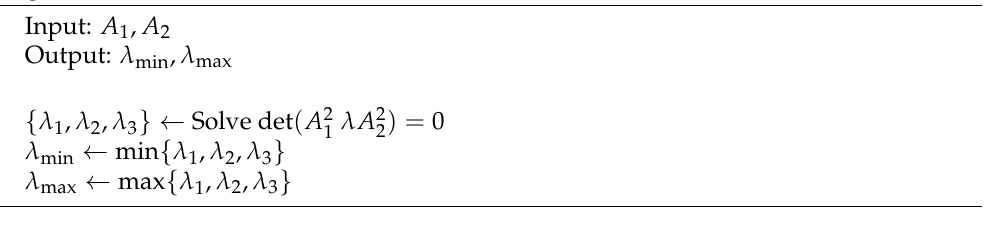
Algorithm A2 Function: Domain of Kurzhanski’s outer bounds